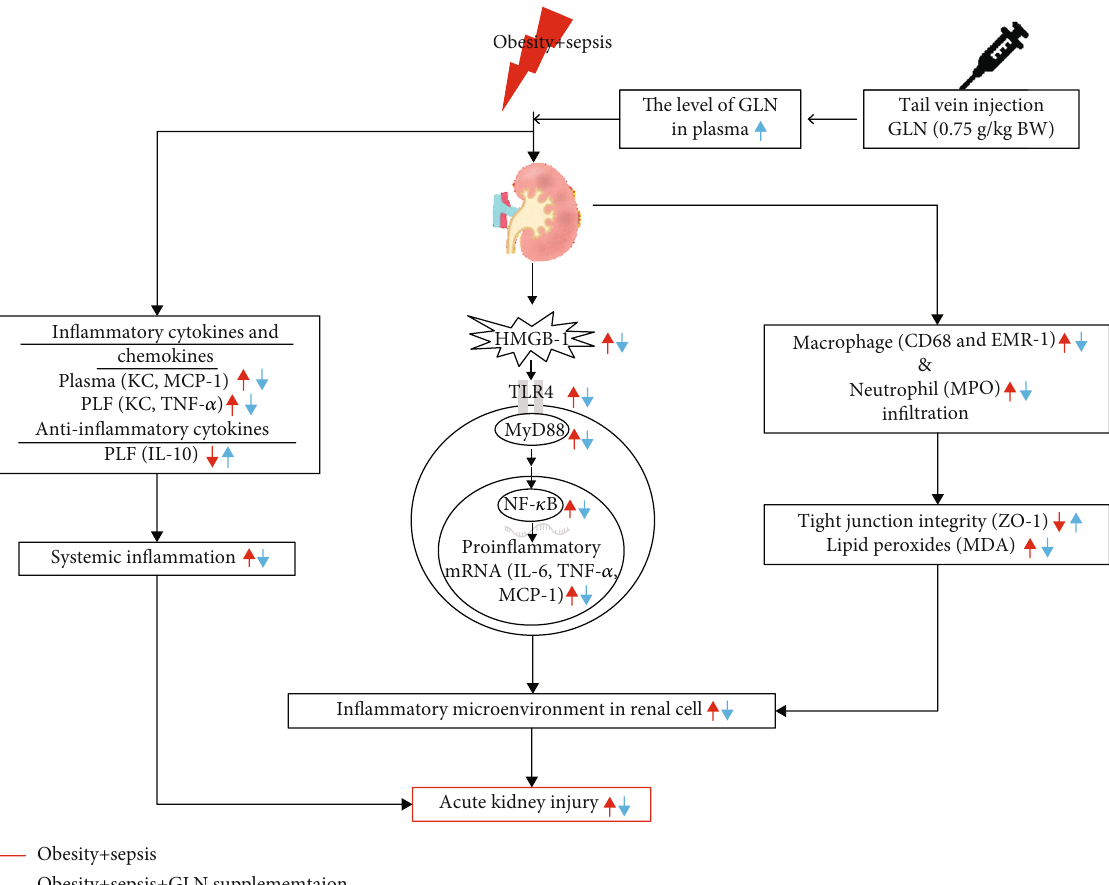
Figure 7: The proposed mechanisms of glutamine (GLN) regulation on attenuating sepsis-induced acute kidney injury (AKI). Obesity exaggerates the severity of sepsis, and AKI is a common complication. Underlying sepsis, immune cells release in fl ammatory cytokines and chemokines that result in systemic in fl ammation. In the kidney, upregulation of HMGB-1 activates the NF- κ B pathway and subsequent downstream in fl ammatory mediator production. Activated macrophage and neutrophil in fi ltration into kidney tissue may worsen the integrity of tight junction and increase the production of lipid peroxides. The in fl ammatory microenvironment within renal cells ultimately leads to AKI. GLN administration increases the plasma levels of GLN, blocks the in fl ammatory pathways, and reduces lipid peroxide production, thus ameliorating the occurrence of AKI. Red line means the e ff ects of obesity complicated with sepsis. Blue line means the e ff ects of GLN administration on obesity complicated with sepsis. CD68: cluster of di ff erentiation 68; CLP: cecal ligation and puncture; EMR-1: epidermal growth factor-like module-containing mucin-like hormone receptor-like-1; HMGB-1: high-mobility group box protein-1; KC: keratinocyte-derived chemokine; IL: interleukin; MCP-1: monocyte chemoattractant protein-1; MDA: malondialdehyde; MPO: myeloperoxidase; MyD88: myeloid di ff erentiation factor 88; NF- κ B: nuclear factor- κ B; PLF: peritoneal lavage fl uid; TLR4: toll-like receptor-4; TNF- α : tumor necrosis factor- α ; ZO-1, zonula